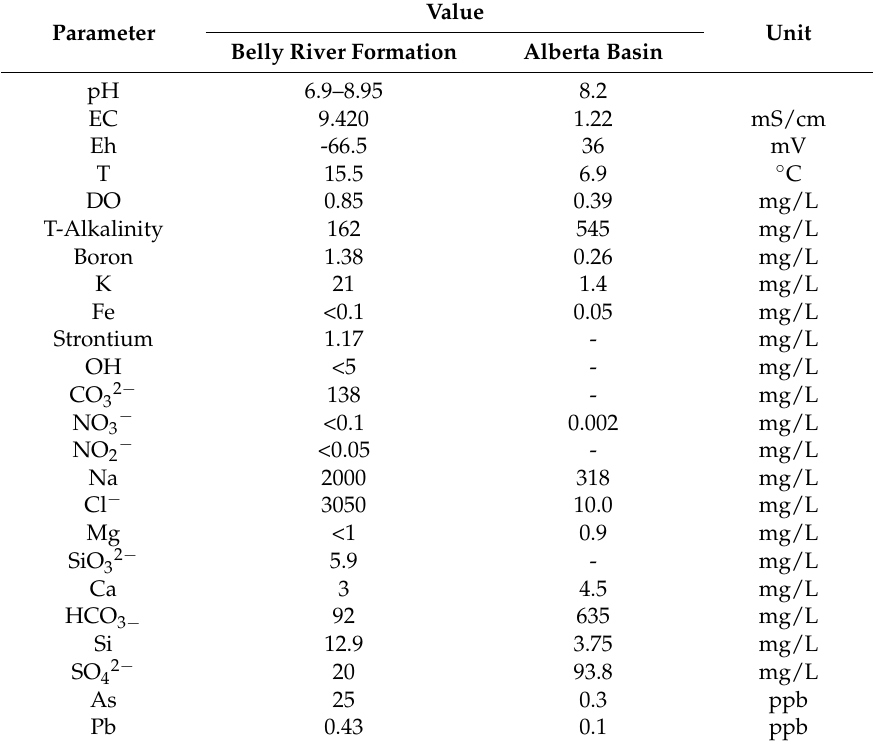
Table 5. Geochemistry of groundwater in both the Belly River formation [60] and Alberta basin [66].